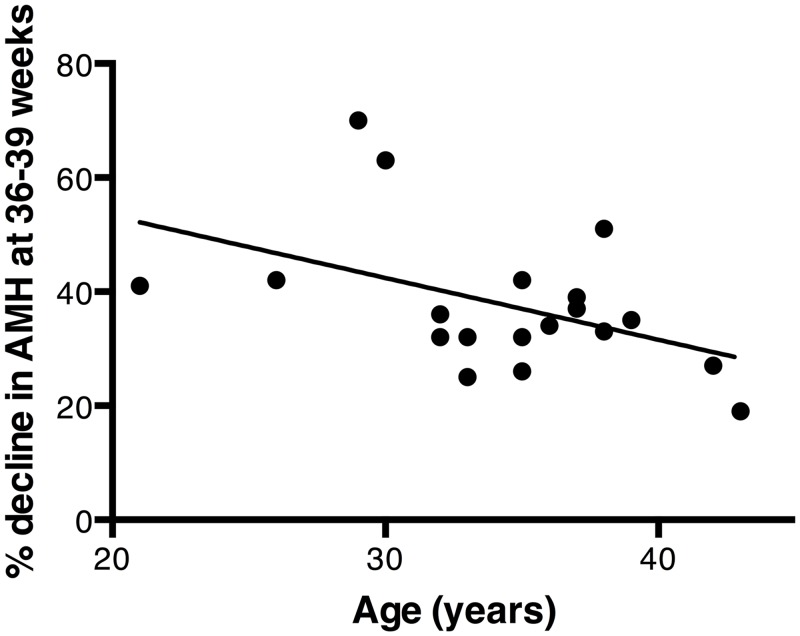
The influence of maternal age on the pregnancy-associated decline in total AMH level.The percentage decrease in total AMH levels between the first trimester and the 36–39 week samples is plotted against the women’s ages. The two parameters were significantly correlated, R = -0.53, p = 0.024.